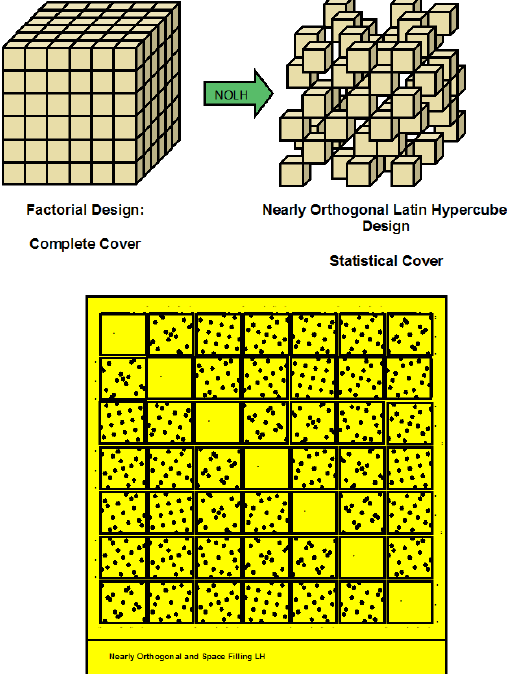
Figure 4. Complete covering and statistical covering of the parameter space. Two simplified